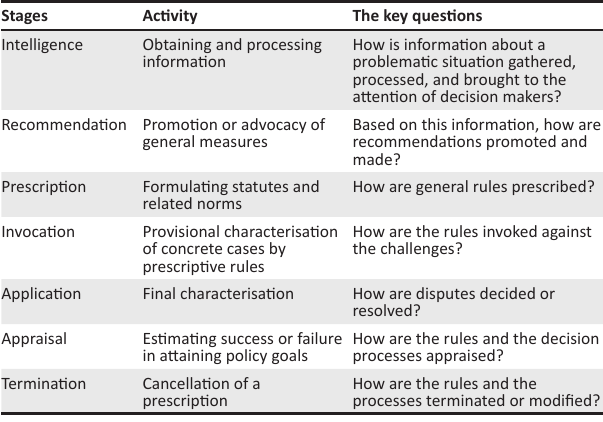
TABLE 1: Key questions that should guide decision makers at each of Lasswell’s seven stages of a policy cycle. Stages